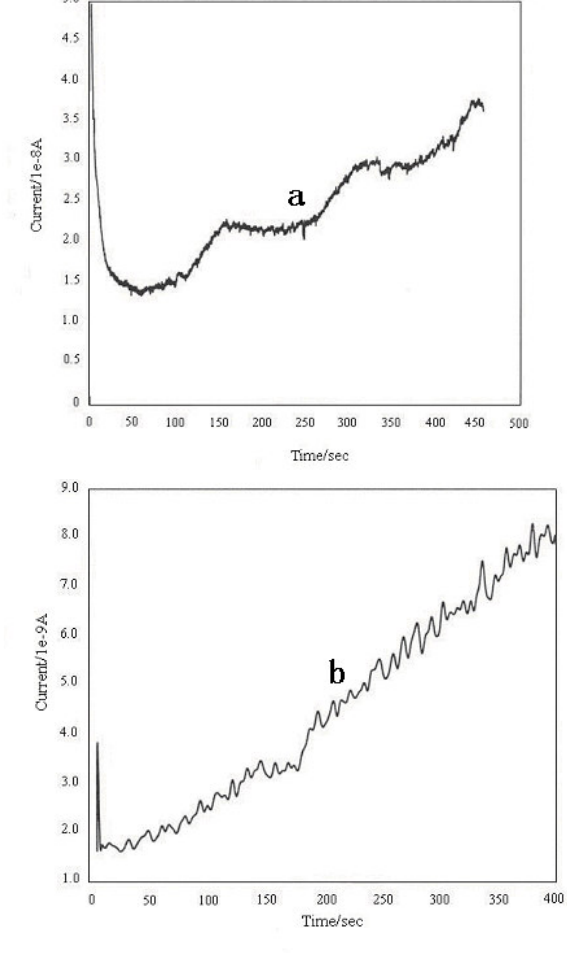
Fig. 3 . current-time curve of the ISO-NOPMC microsensor to the successive additions of NO(curve a: each [NO] increment is 1.4×10 -7 mol/l , curve b: each [NO] increment is 1.4×10 -8 mol/l ) in